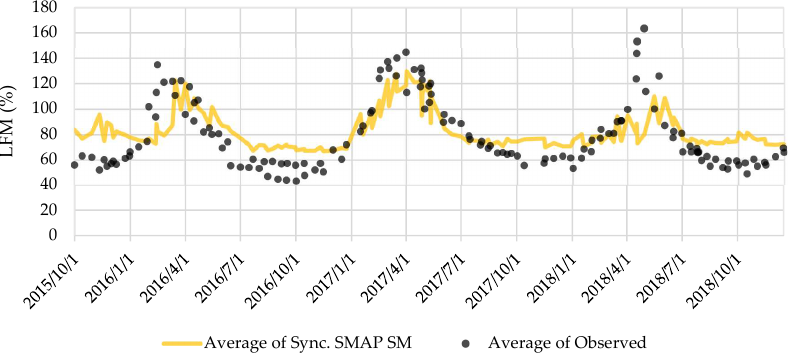
Figure 6. Multi-site average of the observed LFM (black dots) and estimated LFM (yellow line) using synchronized (sync.) SMAP as the single independent variable across three water years from 2015 to 2018.